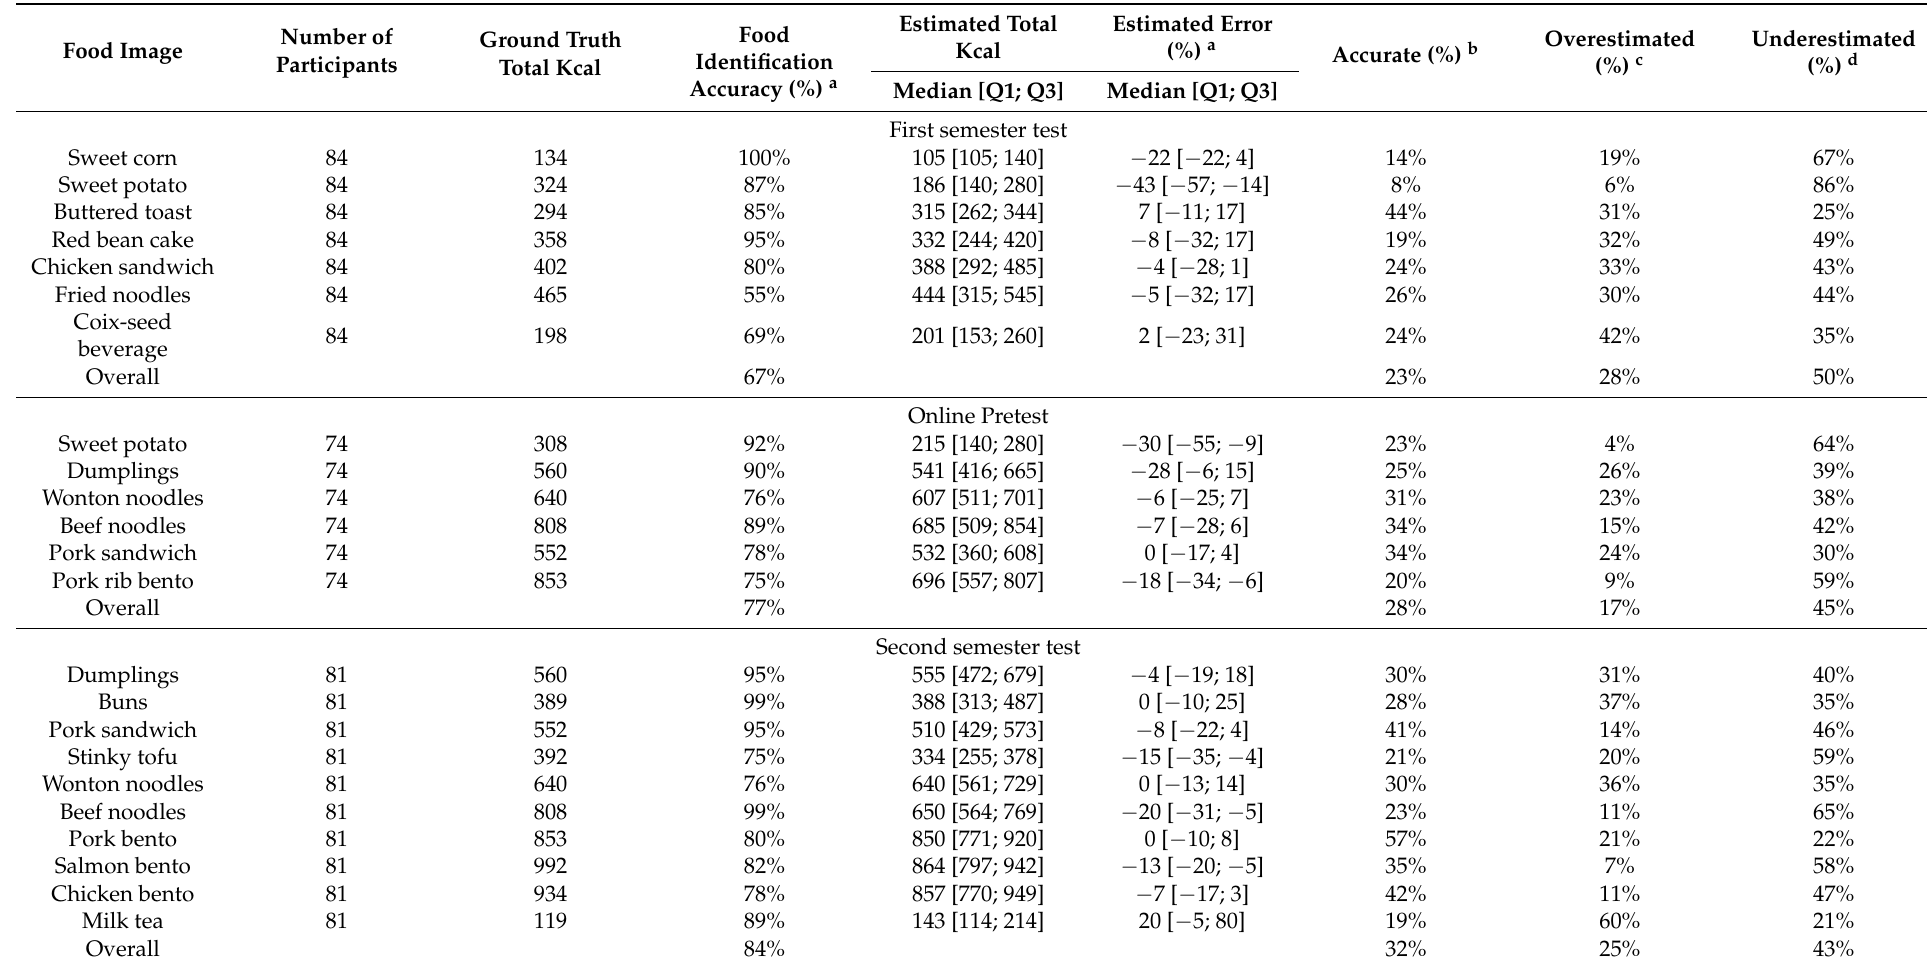
Table 3. Students’ overall performance of food identification and calorie quantification in the first semester ( n = 84), in the online pretest ( n = 74), and in the second semester ( n = 81) of the nutrition practicum